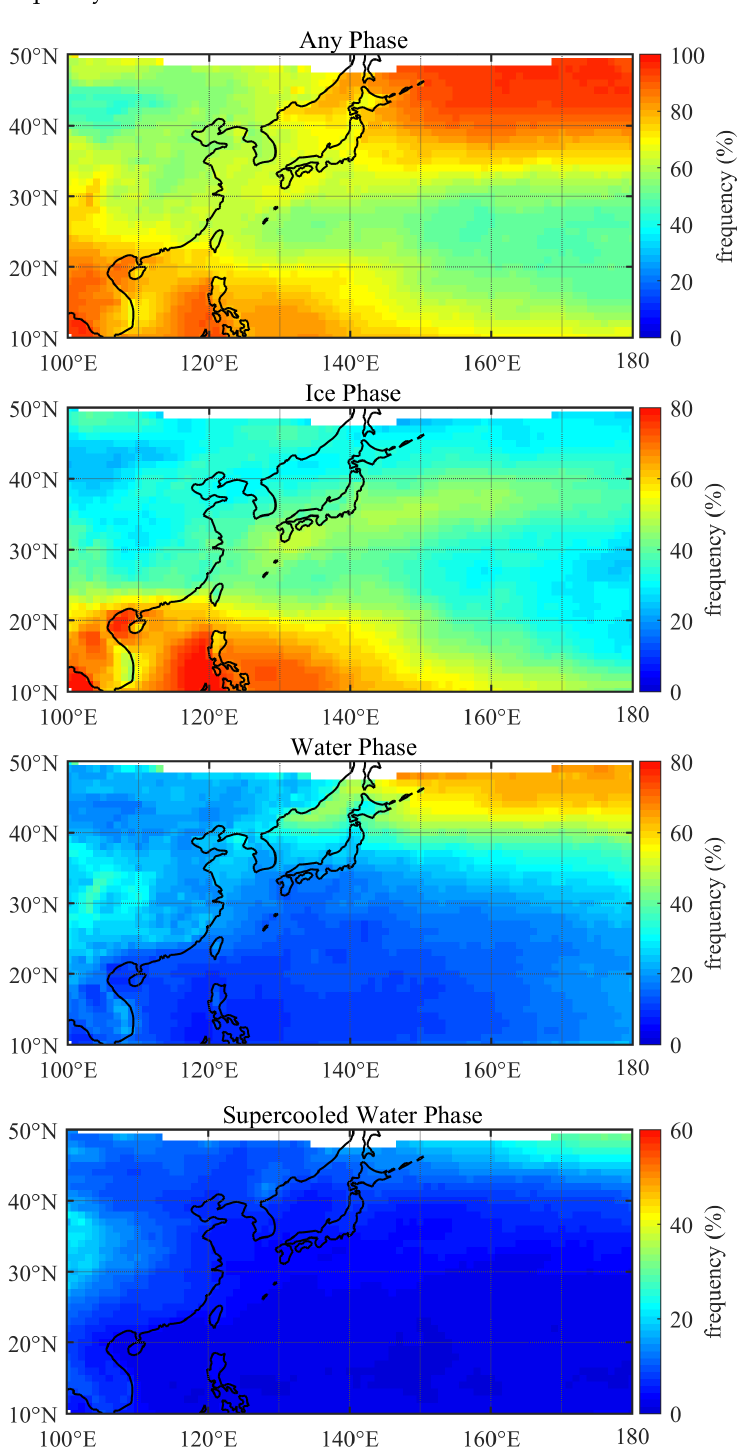
Figure 4. The 1° × 1° gridded seasonally averaged frequency (unit: %) distributions of cloud-top Figure 4. The 1 ◦ × 1 ◦ gridded seasonally averaged frequency (unit: %) distributions of cloud-top phases using the 3-year boreal summer data. phases using the 3-year boreal summer